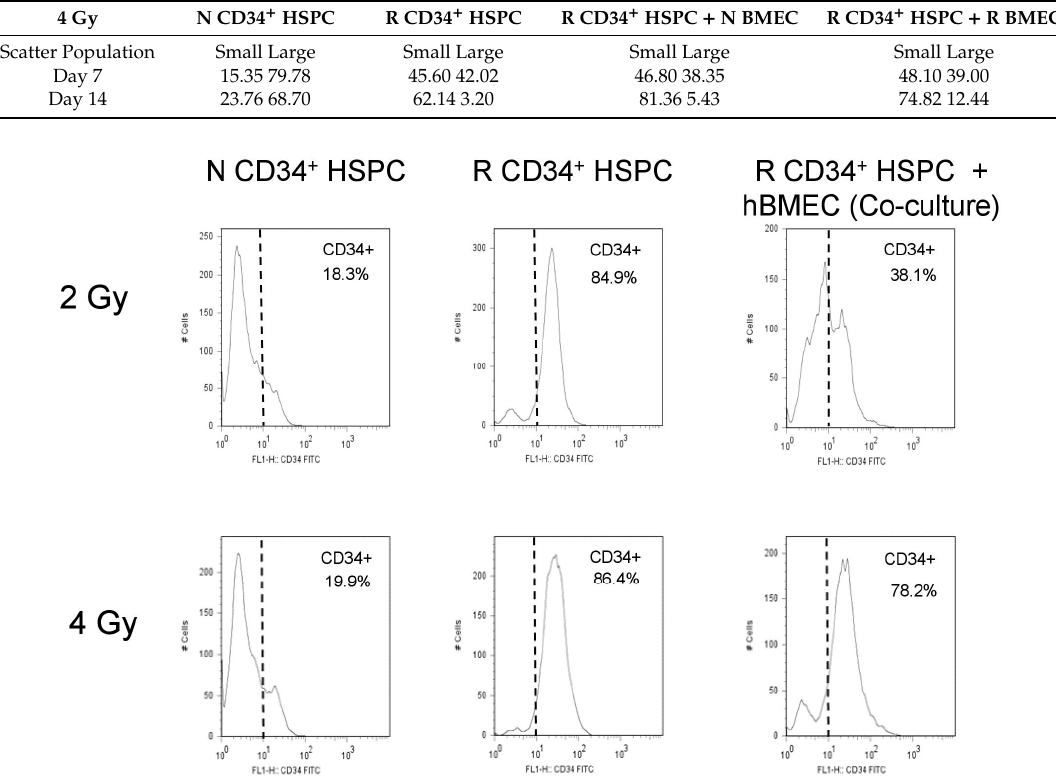
Figure 9. hBMEC altered CD34 expression in HSPC. HSPC were irradiated (2, 4 Gy MF). Cells in coculture were cultured for 24 h with hBMEC postirradiation. All cells were maintained in culture. CD34 expression was analyzed in HSPC by flow cytometry.